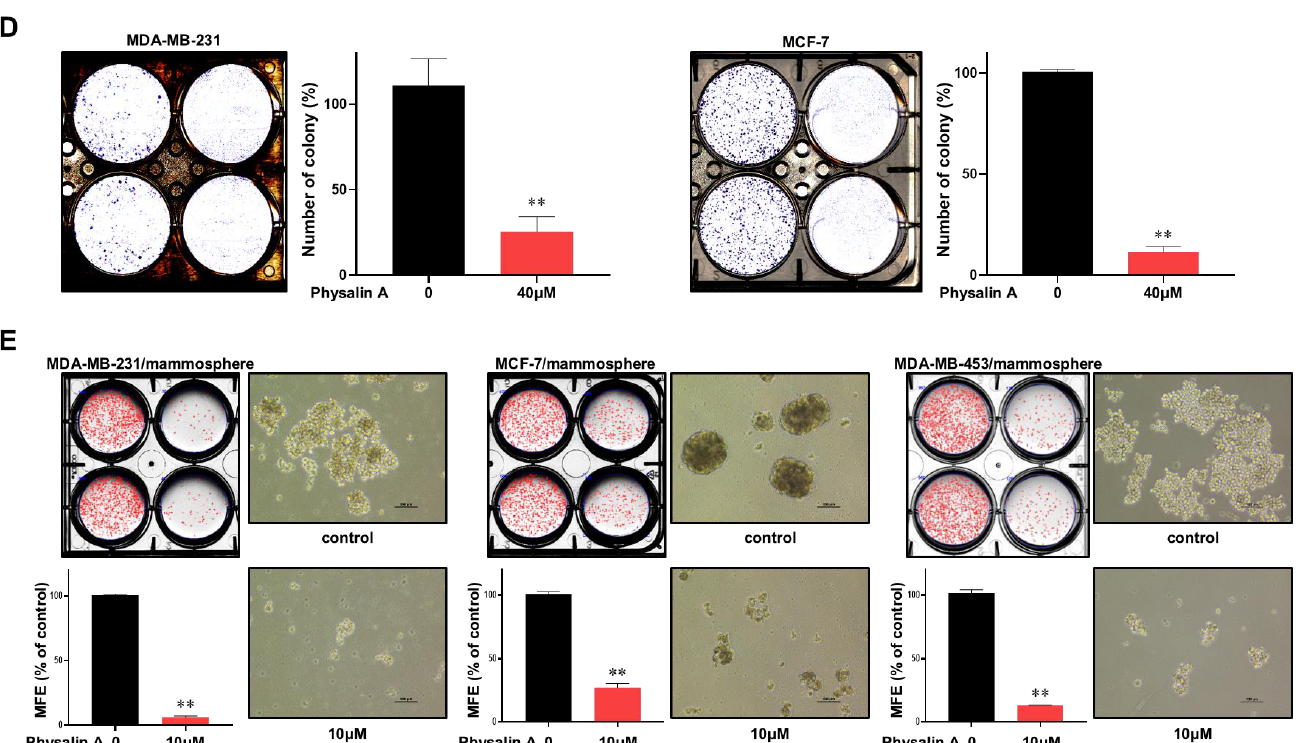
Figure 1. Physalin A inhibits breast cancer cell viability and mammosphere formation efficiency. ( A ) Molecular structure of physalin A. ( B ) Breast cancer cell lines (MDA-MB-231, MDA-MB-453, and MCF-7 cells) were cultured with increasing concentration of physalin A (0, 10, 20, 40, 60, 80, 100 µM) for 24 h. The cytotoxic effect of physalin A was measured using the MTS assay. ( C , D ) Effect of physalin A on colony formation and migration of breast cancer cells. MDA-MB-231 and MCF-7 cells (2 × 10 3 per well) were cultured with/without physalin A for 7 days. The colonies were scanned using a scanner. Migrations with/without physalin A were imaged at 0 and 12 h (scale bar: 1,000 µm). The percent inhibition of cell migration was calculated using untreated well as 100%. ( E ) Physalin A inhibits mammosphere-forming ability. MDA-MB-231 cells (1 × 10 4 per well), MDA-MB-453 (2 × 10 4 cells/well) and MCF-7 cells (4 × 10 4 per well) were cultured in 6-well ultra-low attachment plates with/without physalin A. Representative mammospheres in the photos were captured by inverted light microscopy (scale bar: 100 µm). The mammosphere formation efficiency (MFE) was determined as shown in the graph. Mean ± SD values from three independent experiments are presented. * p < 0.005, ** p < 0.01.